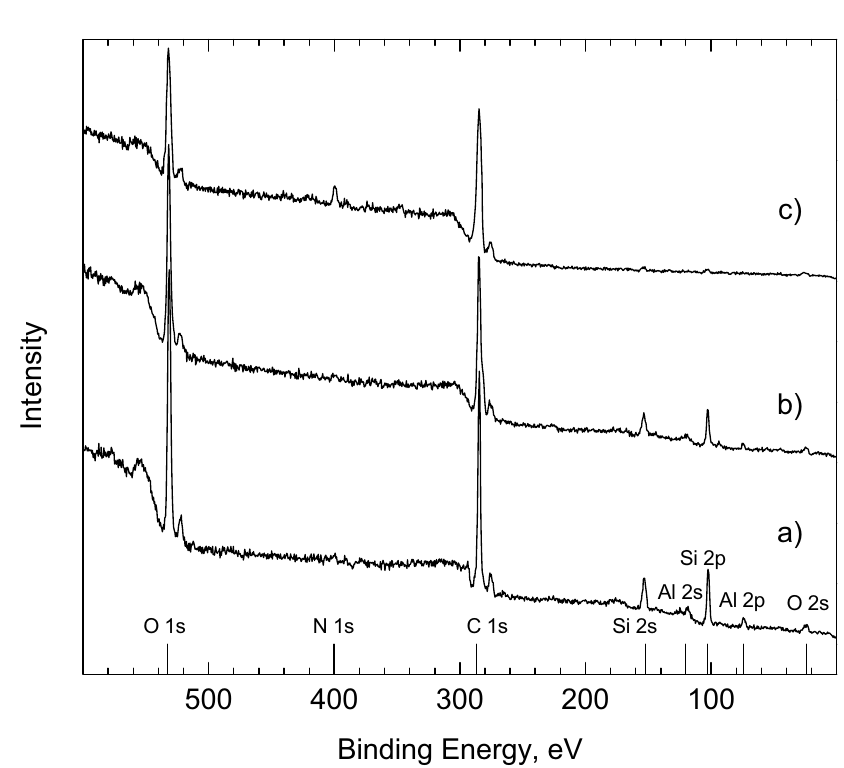
Fig. 7 The XPS survey scans of ODA-clinoptilolite with adsorbed chromate (a) and arsenate (b), and of carbonized clinoptilolite